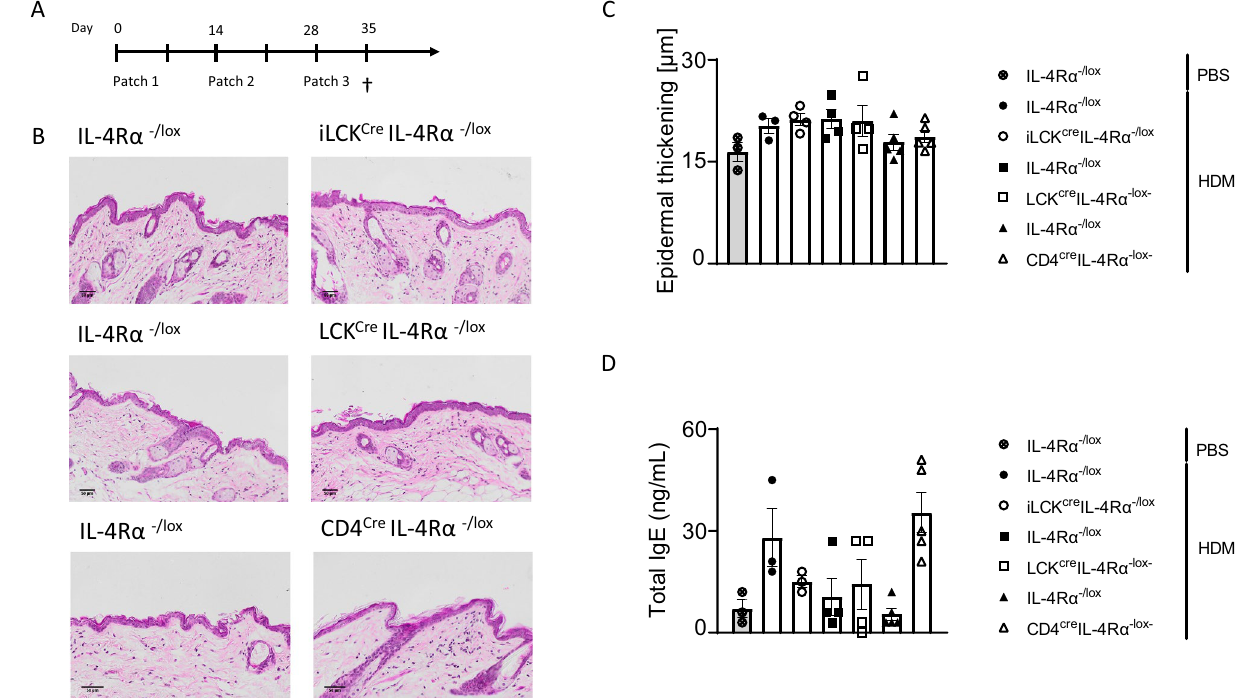
Figure 1. Epicutaneous sensitization with 10ug HDM induces insufficient skin inflammation. (A) Shaved mice (iLCK cre IL-4R ⍺ −/lox , CD4 cre IL-4R ⍺ −/lox , LCK cre IL-4R ⍺ −/lox and their respective IL-4R ⍺ −/lox littermate controls) were epicutaneously sensitised via patch containing PBS or HDM 100 µg at day 0, 14 and 28 and blood and skin were collected at day 35. ( B ) Representative histology images of skin biopsies of ventral side from HDM or PBS treated mice, stained with H&E, scale bar 50 μm. ( C ) Quantification of epidermal thickening using QuPath software. ( D ) Quantification of total IgE serum by ELISA. Shown is one representative experiment with mean ± SD. Statistical analysis was performed using Student t-test Mann–Whitney where*p < 0,05,**p < 0,01 between littermate IL-4Rα –/lox PBS group vs HDM challenged mice. n = 3–5 mice per